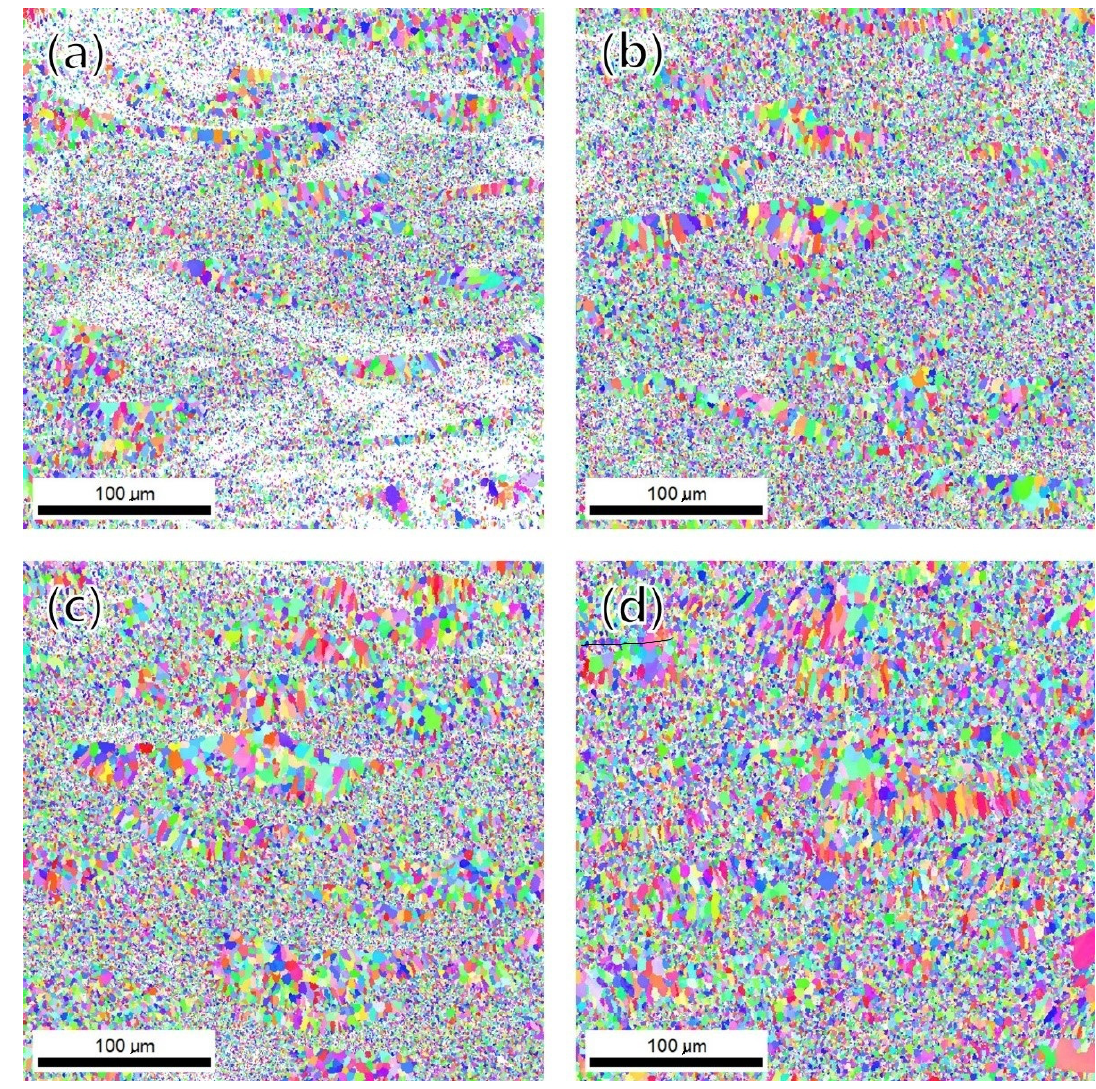
Figure 8. EBSD inverse pole figure (IPF) orientation maps corresponding with grain boundaries on the longitudinal section: ( a ) as-built, ( b ) HT1, ( c ) HT2, and ( d ) HT3 conditions.